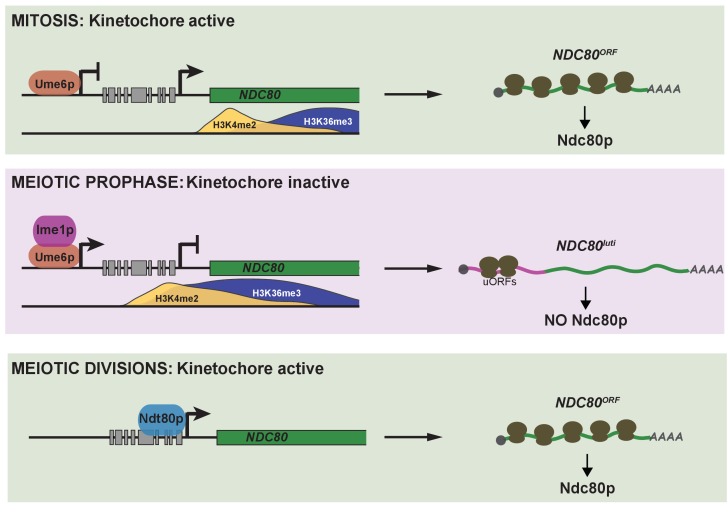
Model of NDC80 gene regulation in budding yeast.During vegetative growth, a stage in which kinetochores are active, a short NDC80 mRNA isoform NDC80ORF is expressed, and the 5’ extended isoform NDC80luti is repressed by Ume6. Translation of NDC80ORF results in Ndc80 protein synthesis (top panel). At meiotic entry, the master transcription factor Ime1 induces expression of NDC80luti. Transcription from this distal NDC80luti promoter silences the proximal NDC80ORF promoter through a mechanism that increases H3K4me2 and H3K36me3 marks over the NDC80ORF promoter (See the accompanying paper Chia et al., for details). NDC80luti does not support Ndc80 synthesis due to translation of the uORFs. The overall synthesis of Ndc80 is repressed in meiotic prophase, and the kinetochores are inactive (middle panel). As cells enter the meiotic divisions, the transcription factor Ndt80 induces NDC80ORF re-expression, allowing for Ndc80 re-synthesis and formation of active kinetochores (bottom panel).